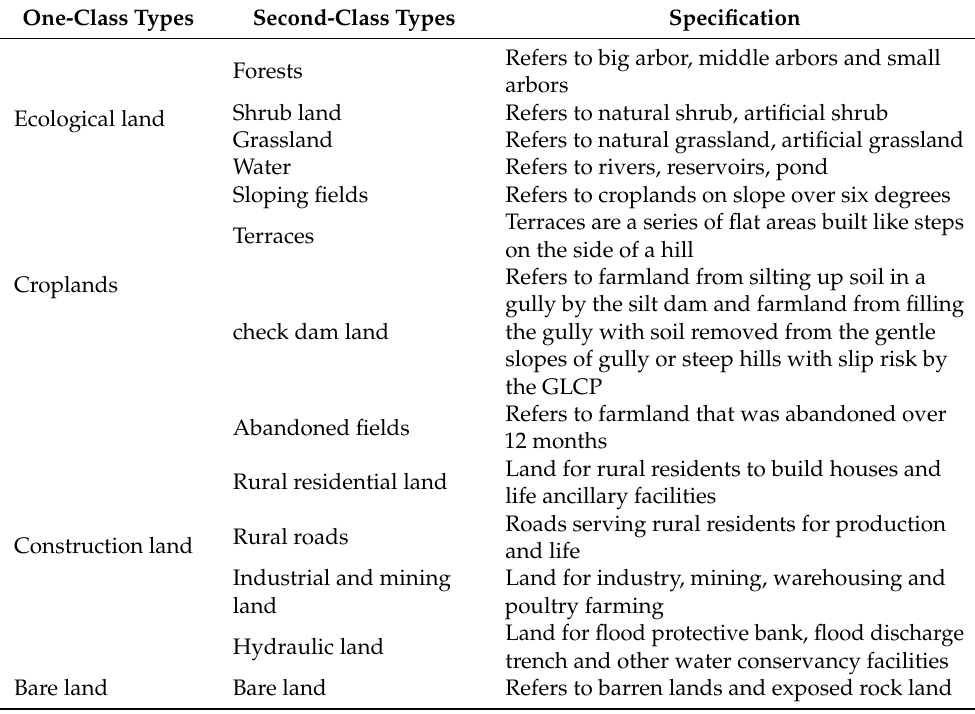
Table 1. Classification of land use types of the study